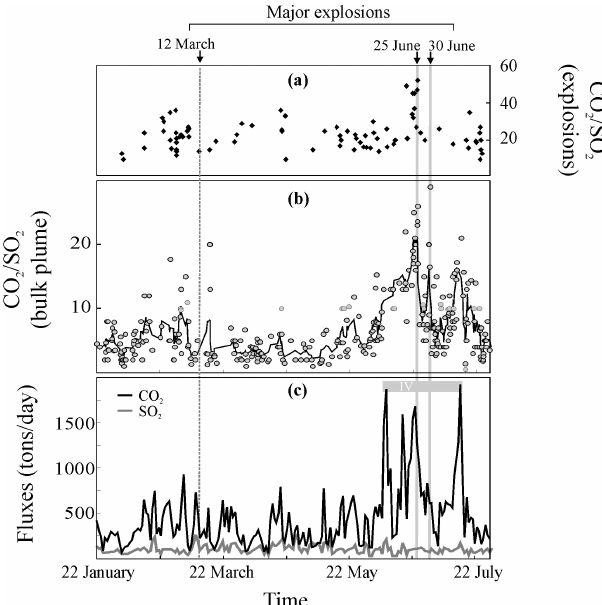
Fig. 3. A detail of plume observations taken in the 22 January to 30 July 2010 period. (a) CO 2 /SO 2 ratios of the syn-explosive gas phase (the gas phase released during the discrete and short-lived ex- plosions of the regular Strombolian activity); (b) CO 2 /SO 2 ratios of the Stromboli’s bulk plume, which is dominantly contributed by passive (quiescent) degassing in-between Strombolian explosions (Burton et al., 2007a); and (c) Daily record of SO 2 fluxes (grey line; derived from the FLAMES network of UV scanning spectrom- eters; Burton et al., 2009) and CO 2 fluxes (black curve). CO 2 fluxes were calculated by combining the daily averages of the bulk plume CO 2 /SO 2 ratio and SO 2